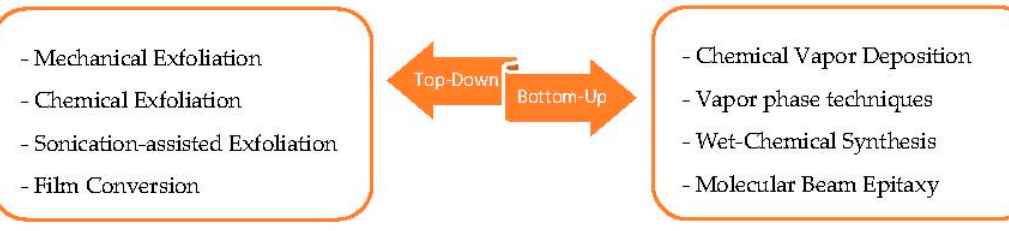
Figure 6. Bottom-Up and Top-Down approaches for the synthesis of thin 2D Mo X 2 materials.